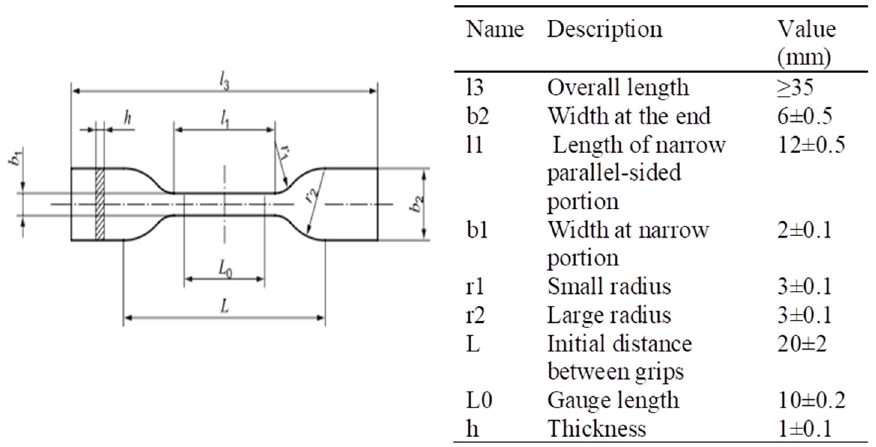
Figure 2. Specimen geometry and dimensions.